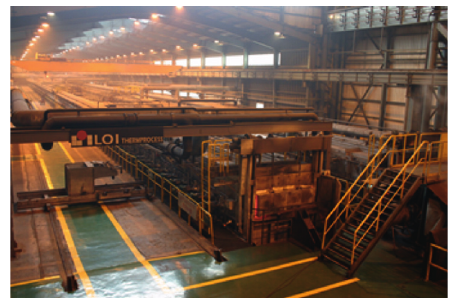
Figure 7: Thin-plate mill hot rolling production site.